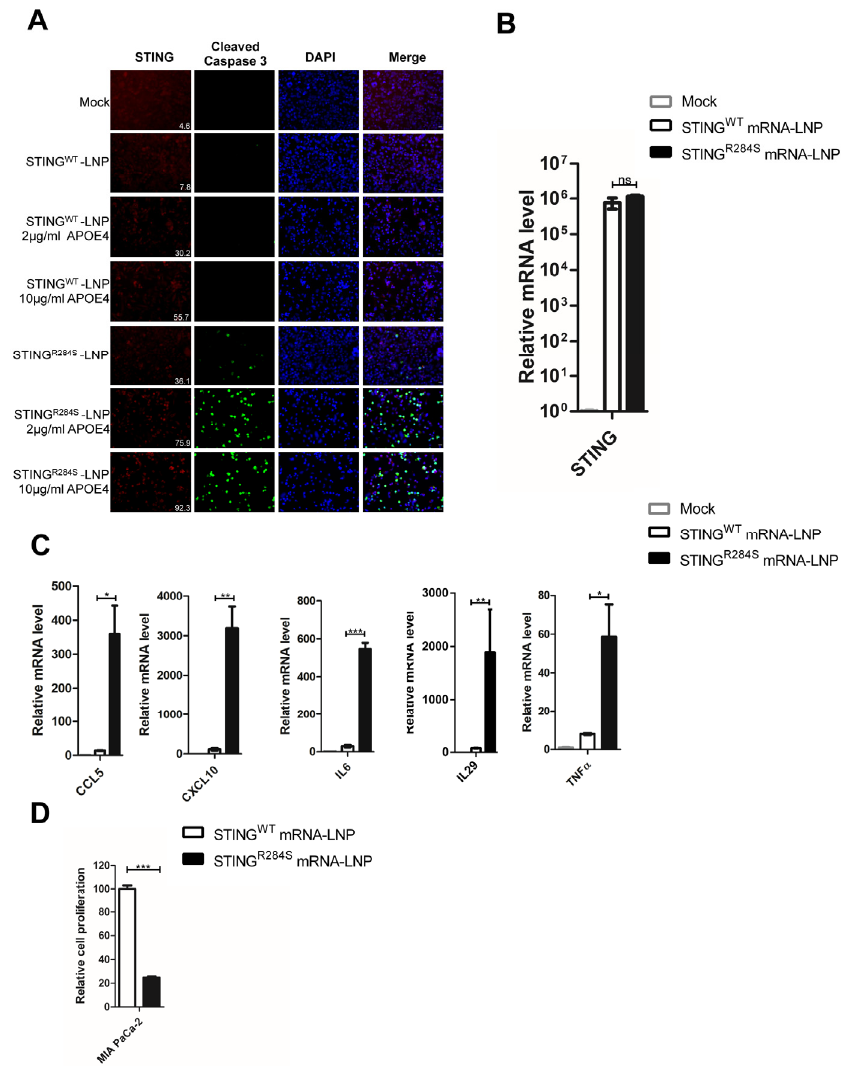
Figure 5. STING R284S delivered by mRNA-LNP activates essential antitumor cytokine production and kills PDAC cells. ( A ) 2 × 10e 4 MIA PaCa-2 cells were treated with 1 µg STING WT or STING R284S mRNA-LNP, which were pre-mixed with the indicated concentration of the recombinant human APOE4 protein. Untreated MIA PaCa-2 cells were used as a negative control (mock). At 16 h post-treatment, cells were stained for STING (Red) and Cleaved Caspase-3 (Green). The mean fluorescence intensity of the STING images was quantified using ImageJ software and denoted at the bottom right corner. Scale bar: 20 µm. ( B , C ) 10e 4 MIA PaCa-2 cells were treated as in ( A ) using 10 µg/mL human APOE4 protein. At 16 h post-treatment, STING WT and STING R284S expression were confirmed by RT-qPCR ( B ), and the mRNA levels of the indicated genes were measured by RT-qPCR and normalized to the GAPDH mRNA level ( C ). The values for untreated cells (Mock) were set to 1. ( D ) 0.5 × 10e 4 MIA PaCa-2 cells were treated as in ( B ). At 16 h post-treatment, cell viability was measured by the CellTiter-GLO 3D cell viability assay. Error bars represent the SEM of three independent experiments. (ns: not significant, * p < 0.05, ** p < 0.01, *** p < 0.001).